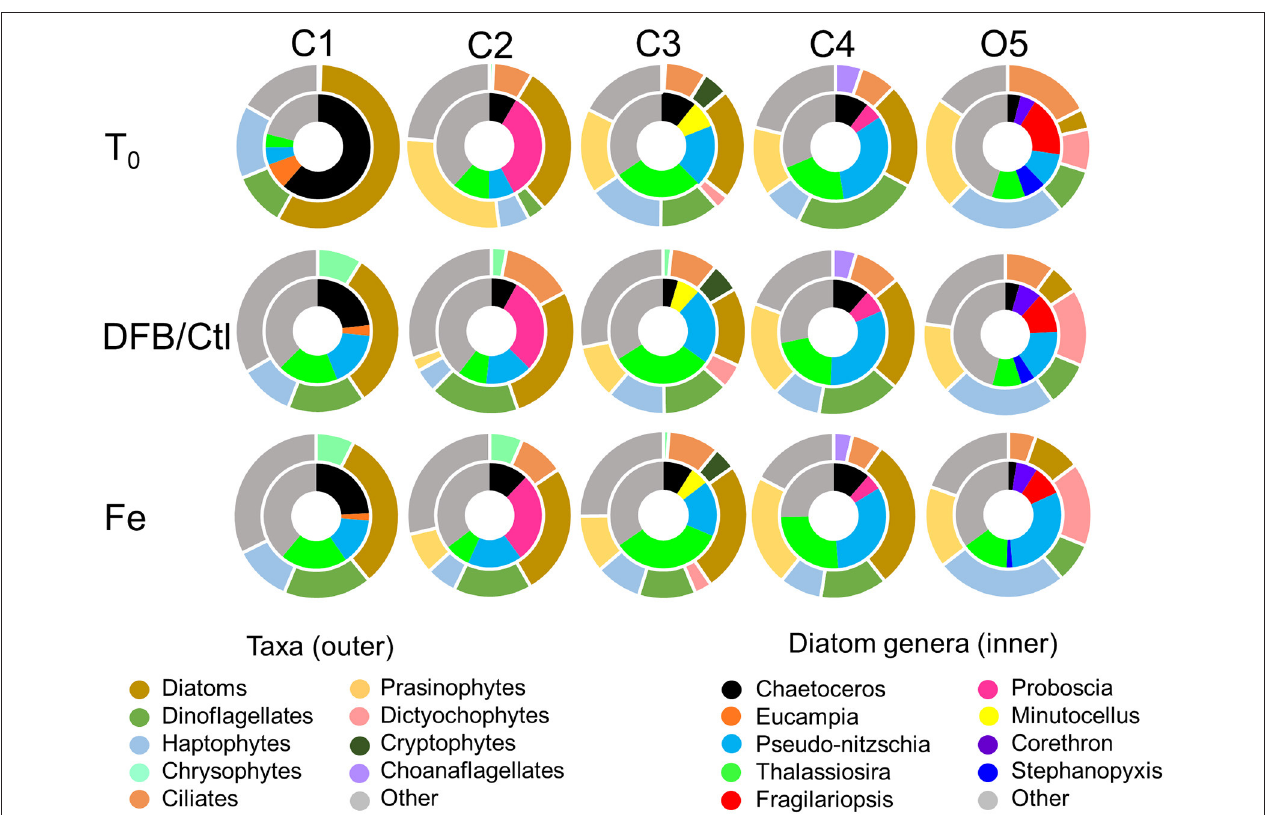
FIGURE 3 | The average transcript proportions of phytoplankton taxa (outer charts) and diatom genera (inner charts) from initial seawater (T 0 ) and during the first time point (T 1 ; see Supplementary Table 1) within the Fe addition (Fe) and DFB addition (DFB) treatments at each site. Note that for site O5, the T 2 control (Ctl) treatment is provided as the Fe-limited